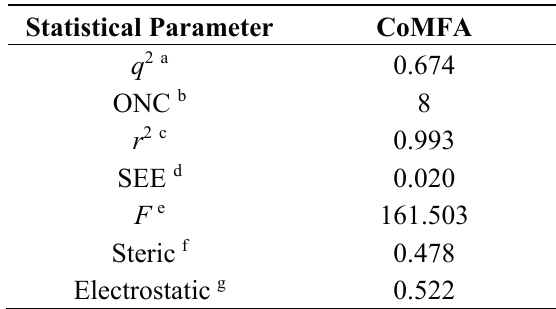
Table 3. Statistical parameters of the CoMFA model.